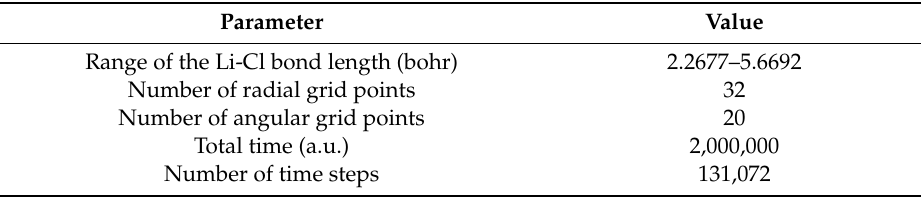
Table 1. Grid and time parameters used in the present OCT